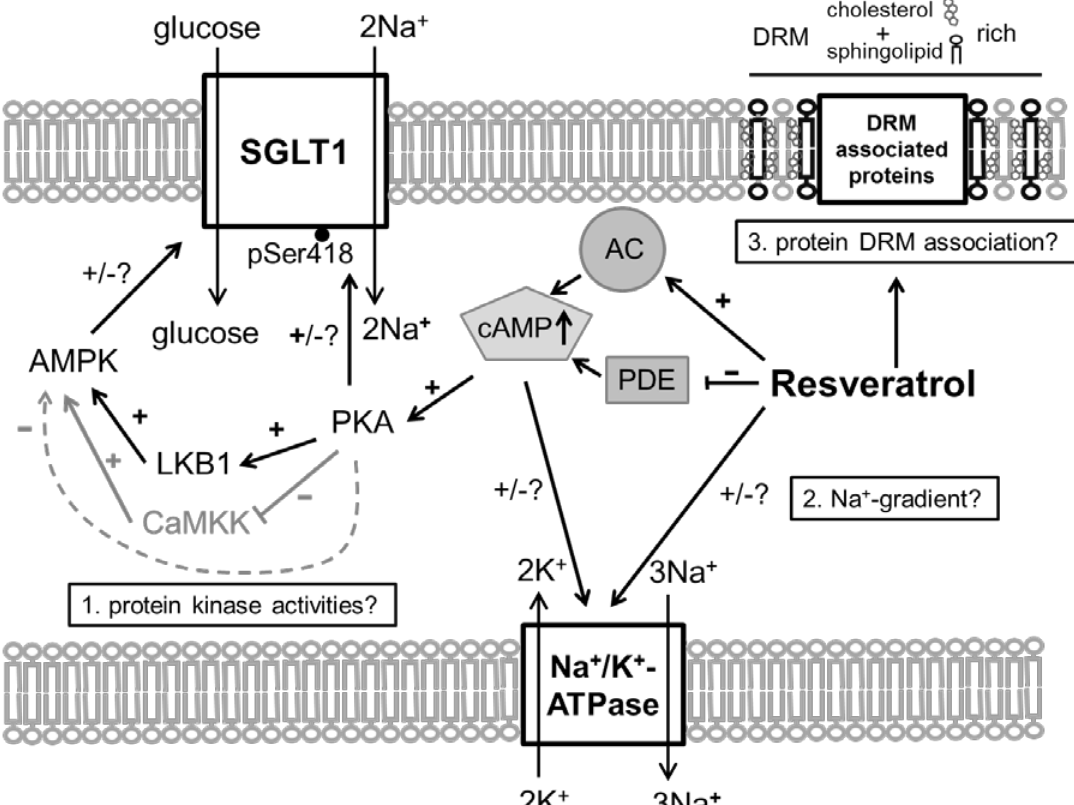
Figure 1. Schematic illustration of how Resveratrol (RSV) may affect intestinal glucose transport. 1. The activation of adenylate cyclase (AC) [22,23] and inhibition of phosphodiesterases (PDE) [21] and the subsequent increased in intracellular cyclic adenosine monophosphate (cAMP) levels are likely to activate protein kinase A (PKA) that is able to phosphorylate sodium–glucose-linked transporter 1 (SGLT1) at Ser418 with species-dependent effects [9,10]. PKA is also able to modulate the activity of the AMP-activated protein kinase (AMPK) via changing the activities of AMPK activating upstream kinases (liver kinase B1 (LKB1) activation [25,26], calcium/calmodulin-dependent protein kinase kinase (CaMKK) inhibition [29]) or by direct phosphorylation of AMPK (inhibition) [28]. 2. Resveratrol may (cAMP-mediated) exert effects on the Na + /K + -ATPase activity [30,31] and therefore change the driving force for Na + -coupled transport processes as the absorption of glucose and alanine. 3. Since Resveratrol is known to affect membrane properties and influences the formation of detergent resistant membrane fractions (DRM) [32,35], the association of nutrient transport proteins with DRMS and therefore their activity may be changed by Resveratrol.